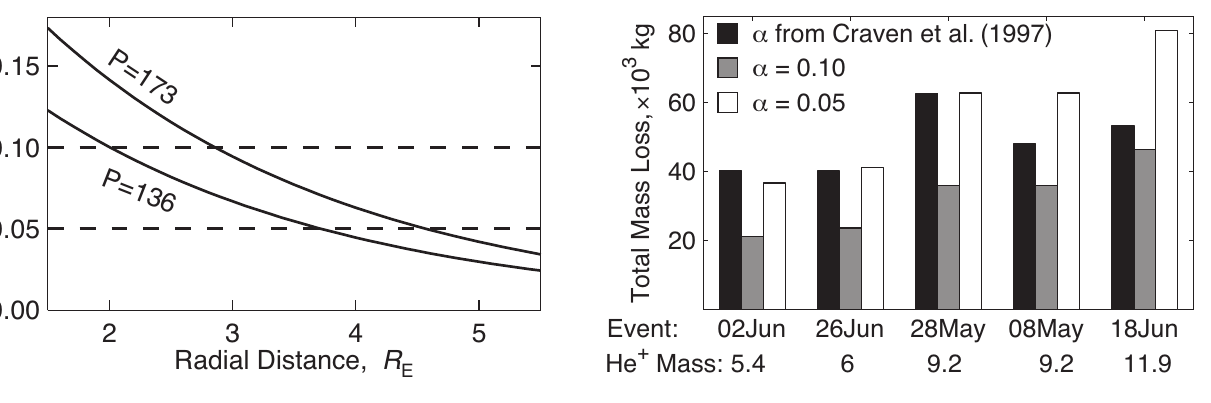
Fig. 7. The He + to H + density ratio from the Craven et al. (1997) formula as a function of radial distance for the minimum ( P = 135) and maximum ( P = 172) solar activity of the five study intervals.